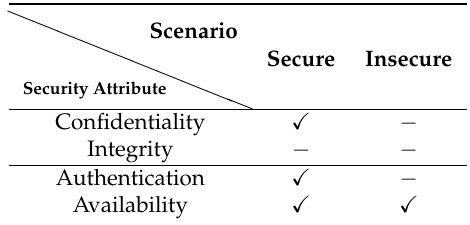
Table 10. Security attributes assured in each of the proposed